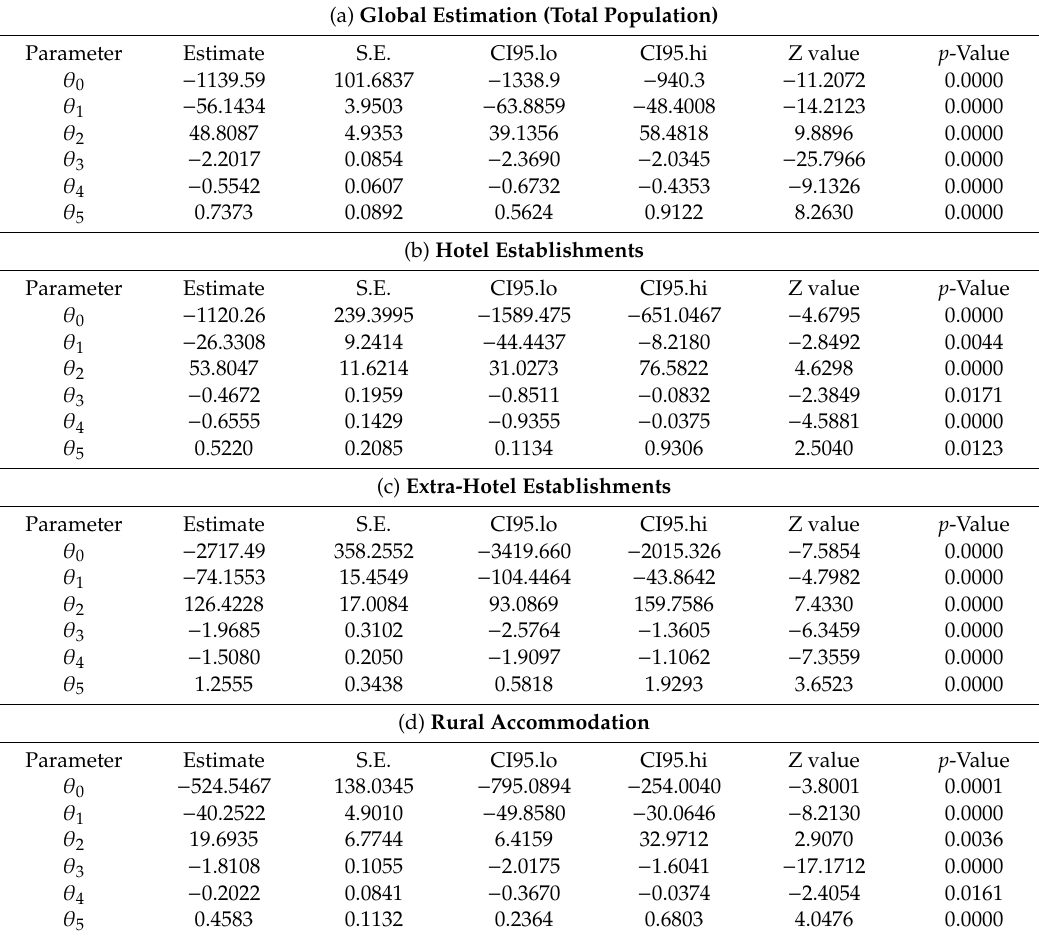
Table 8. Estimation of model (7) λ ( u ,x ) = exp ( θ 0 + θ 1 x + θ 2 y + θ 3 x 2 + θ 4 y 2 + θ 5 xy )